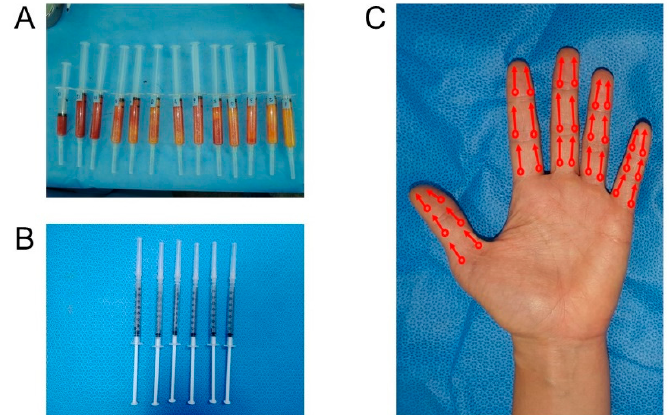
Figure 1. Preparation and injection of autologous fat tissue-derived stromal vascular fraction. ( A ) Harvested autologous adipose tissues. ( B ) Prepared stromal vascular fraction (SVF) mixtures for injection after the refinement. ( C ) Injection sites and needling directions of SVF mixtures. Circles indicate entry points of SVF injections, and arrows indicate directions of inserted needles using retro-tracing technique.